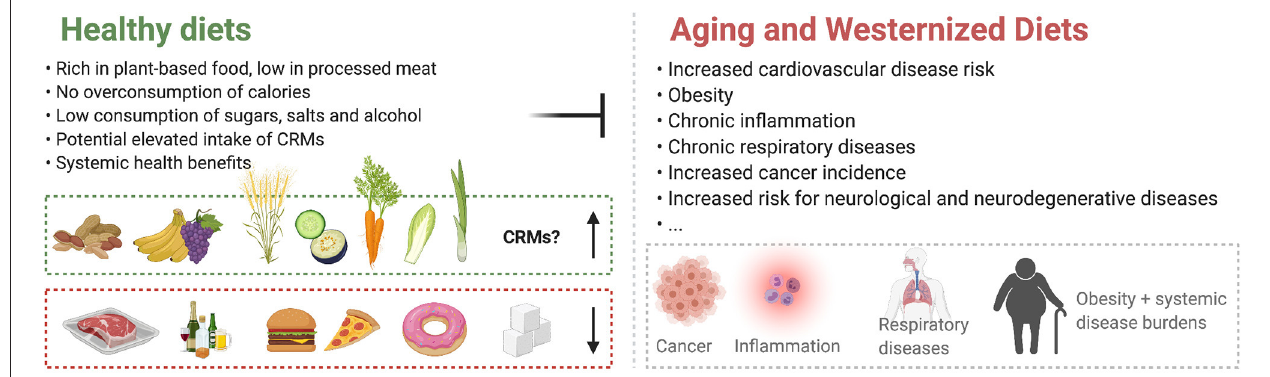
FIGURE 1 | Healthy diet plans stand opposite to Westernized Diets and counteract age-associated deteriorations. The contribution of Caloric Restriction Mimetics (CRMs) to the effects of healthy diets is currently largely undetermined. levels of D-allulose (e.g., 0.5 mg/100 g in coffee, 130.6 mg/100 g in Worcester sauce)